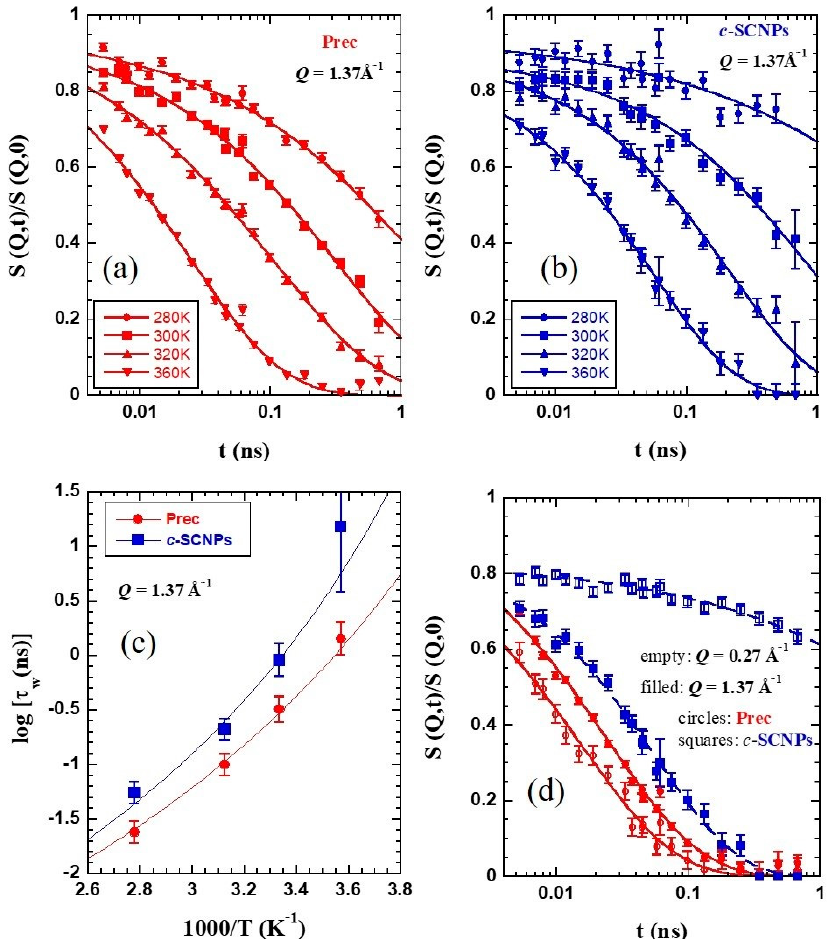
Figure 5. Normalized dynamic structure factor at Q ≈ Q max of ( a ) Prec and ( b ) c -SCNPs samples at different temperatures, ( c ) temperature dependence of the collective characteristic times from NSE at Q = 1.37 Å − 1 and ( d ) a comparative between Prec and SCNPs samples at Q ≈ Q max and a representative Q value in the ILS region at 360 K. Lines are fits of stretched exponentials functions for the dynamic structure factor and of the Vogel-Fulcher equation for the characteristic times. The difference in the dynamical behavior is even more evident when the comparison of the NSE results is performed at Q values below Q max , in the intermediate length scales (ILS) regime. This is illustrated in Figure 5d for a Q-value of 0.27 Å − 1 . While for the linear chains the decay of the density correlation function is faster than at Q max , for the c -SCNPs the dynamic structure factor displays a much more pronounced stretching and decays at much longer times (more than one decade) than the inter-molecular correlations. The blue circles in Figure 6a–c show that this effect is found over a large Q-range below the struc- ture factor peak. In particular, collective motions appear to be frozen in the accessed dy- namic window for Q =0.15 Å − 1 . Thus, the presence of cross-links strongly hampers the re- laxation of collective motions of the chains in this regime.